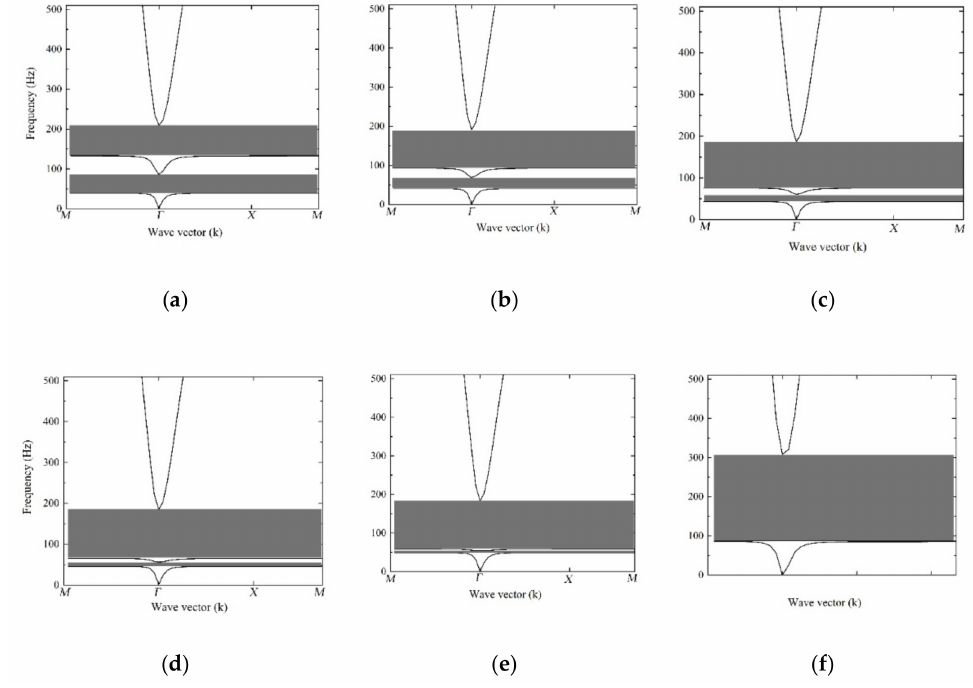
Figure 10. Band diagram for different cavity structures ( a ) b = 25 mm; ( b ) b = 20 mm; ( c ) b = 15